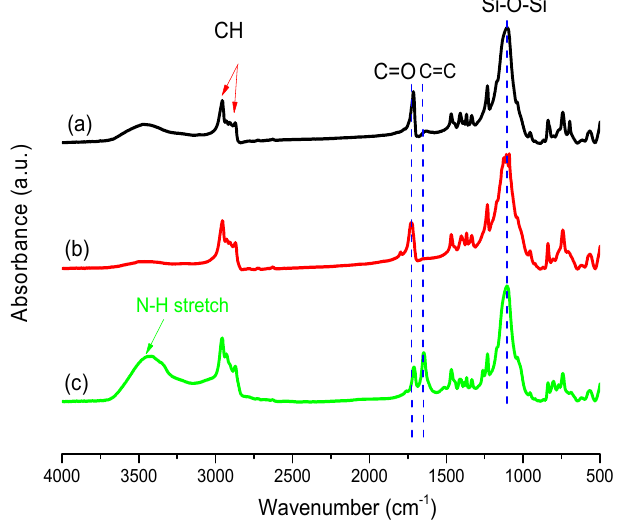
Figure 3. FTIR spectra of the monomers: ( a ) MIPOSS; ( b ) MIPOSS-Br; and ( c ) MIPOSS-NHBu.